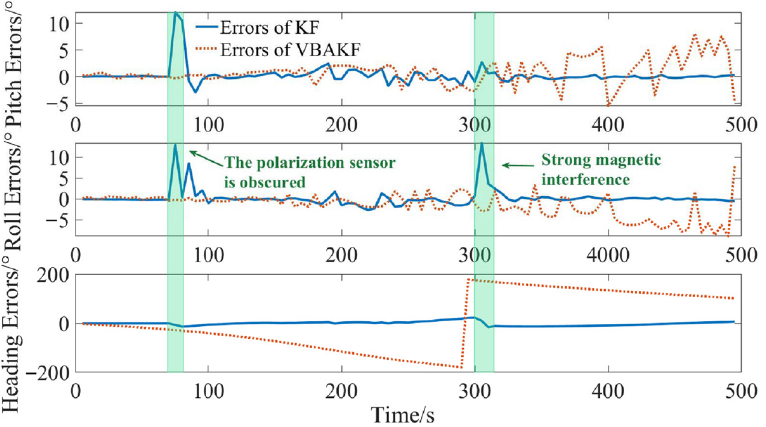
Figure 7. The three-dimensional attitude estimation results with the serious interference cases.